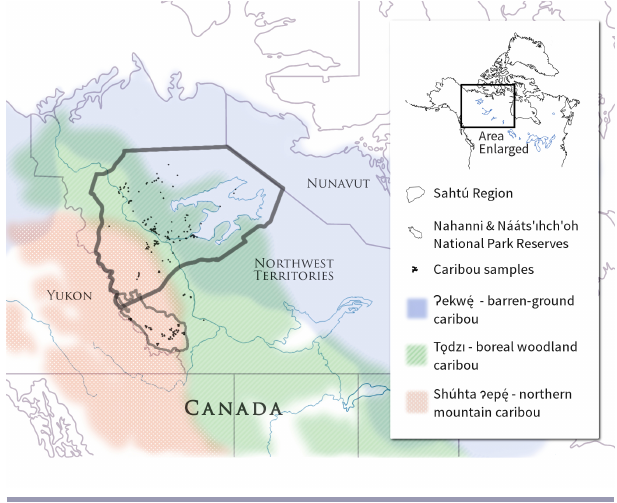
Fig. 1 . The Sahtú region of the Northwest Territories, Canada, includes the overlapping ranges of three types of caribou ( Rangifer tarandus ): to ̨ dzı (boreal woodland caribou; striped green), ɂ ekwe ̨́ (barren-ground caribou; blue), and shu ́ hta ɂ epe ̨́ (northern mountain caribou; stippled orange). Small black dots represent locations of caribou fecal, tissue, and blood strip samples collected in the Sahtú Region and Nahanni National Park Reserve, Northwest Territories,